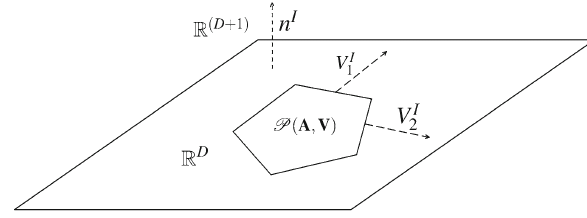
Fig. 1 A D-polytope P ( A , V ) embedded in R ( D + 1 ) with normal n I . ,..., V I ) are the unit outward normal vectors of The vectors V = ( V I F 1 the (D-1)-dimensional faces of P ( A , V ) in R D where P ( A , V ) lies, ,..., A I ) are the areas of the (D-1)-dimensional faces and A = ( A I √ √ F 1 = ,..., V IJ = of P ( A , V ) . The bi-vectors V IJ 2 n [ I V J ] 2 n [ I V J ] F F 1 1 are the unit outward normal bi-vectors of the (D-1)-dimensional faces of P ( A , V ) in R ( D + 1